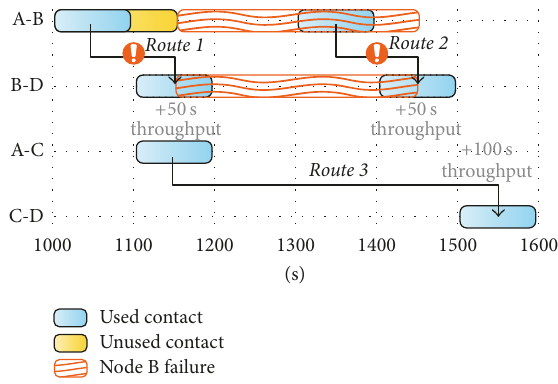
Figure 4: Failures in a DTN